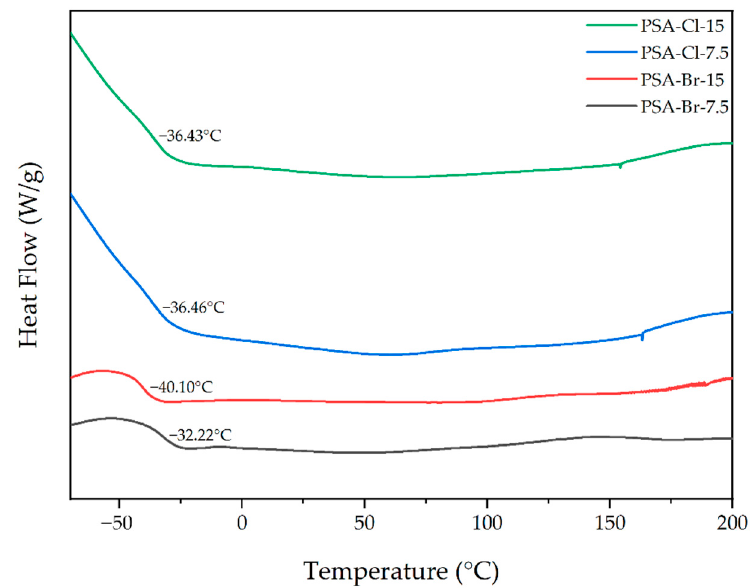
Figure 6. DSC thermograms of the cross-linked PSAs.